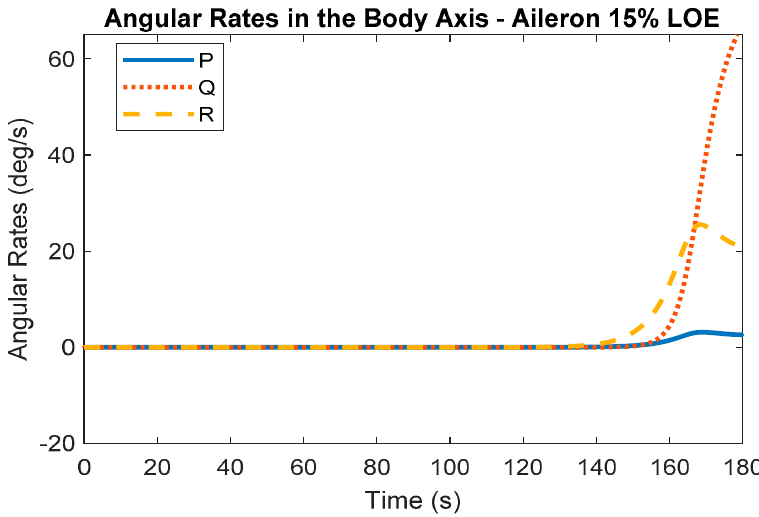
Figure 11. Angular rates in the body axis for the aileron 15% LOE fault.